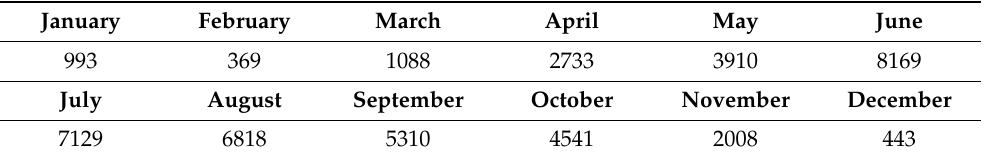
Table 9. Forecasting results for 12 periods in 2021 by Holt’s exponential smoothing method with smooth outliers and an unexpected growth factor of